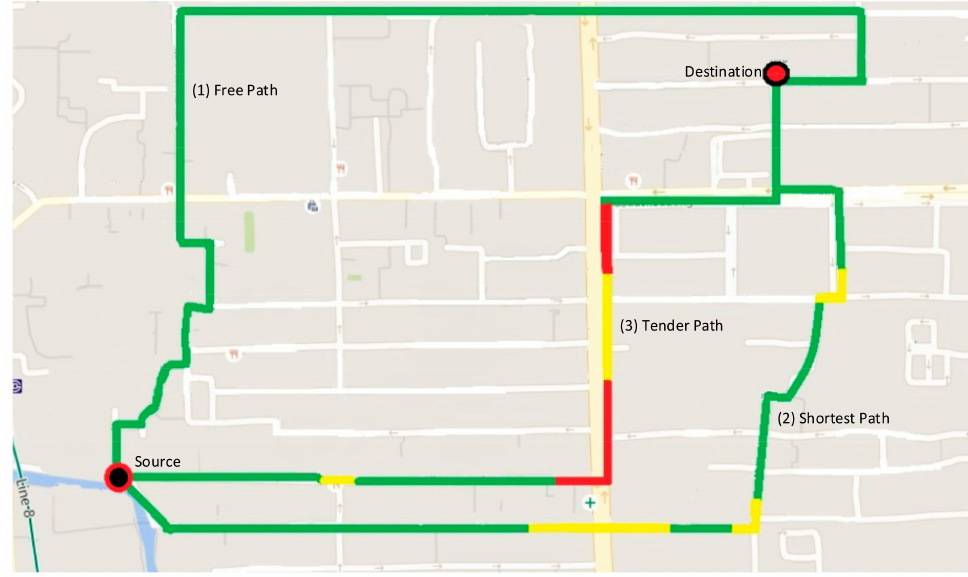
Figure 2. The three types of